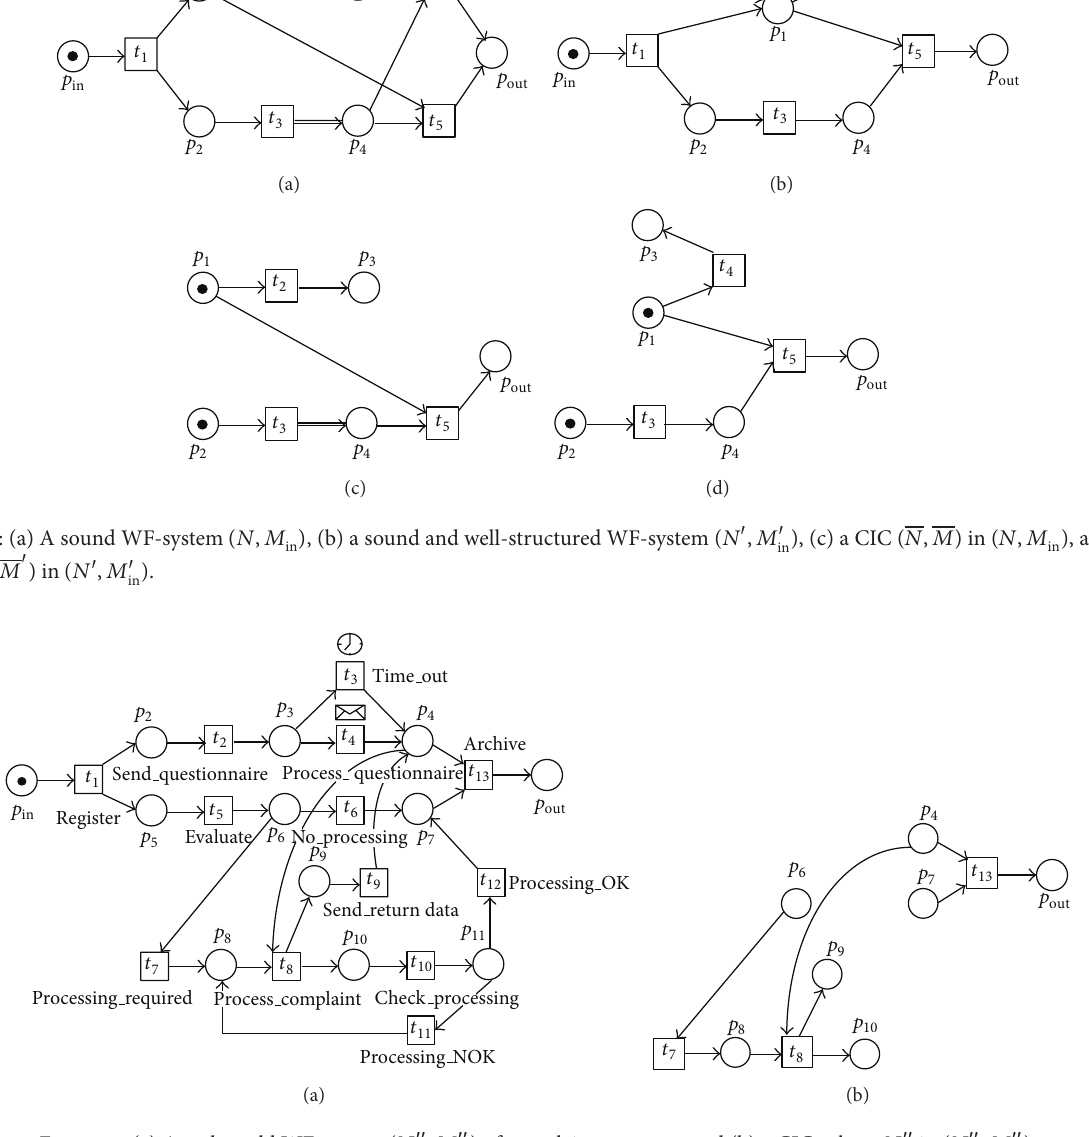
) of complaint processes and (b) a CIC subnet 𝑁 󸀠󸀠 in ( 𝑁 󸀠󸀠 ,𝑀 󸀠󸀠 in